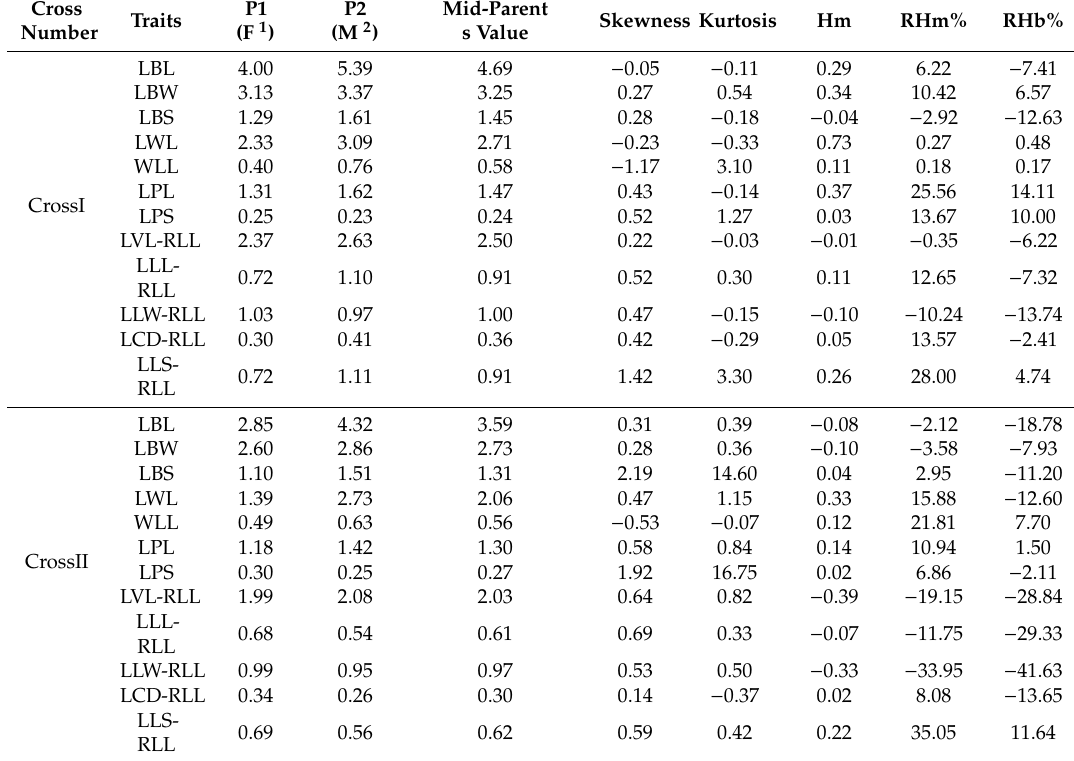
Table 3. The basic statistical characteristics and heterosis of leaf traits in F 1 generations from two crosses. Cross Traits Number